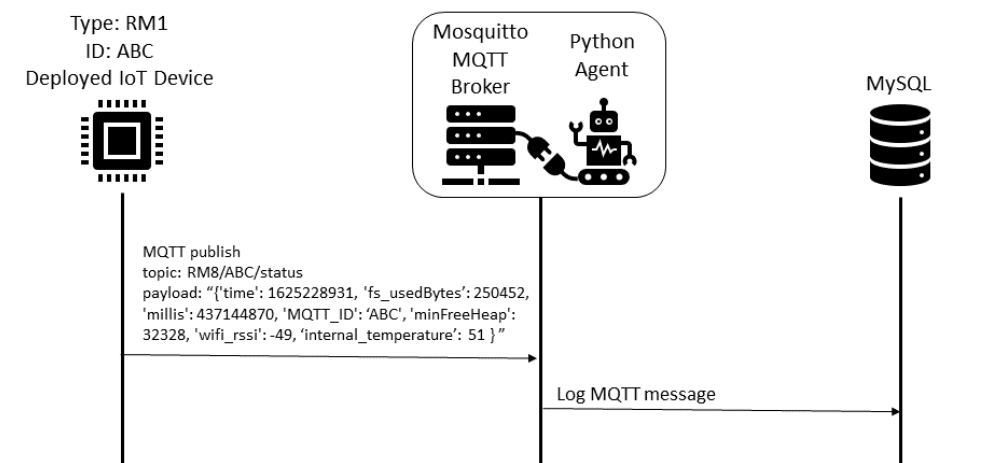
Figure 8. Deployed IoT device status data collection with periodic sending.